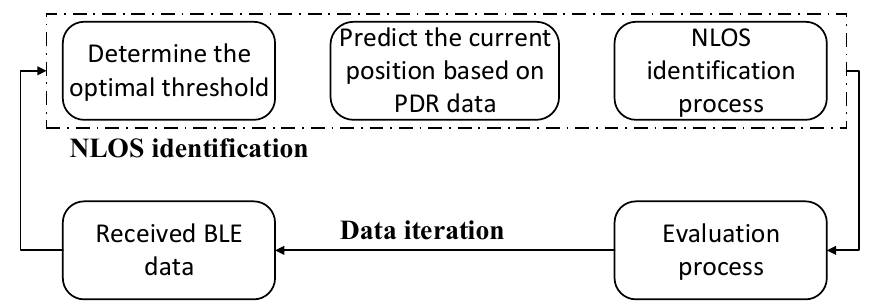
Figure 13. The NLOS rate versus the mean RMSE.